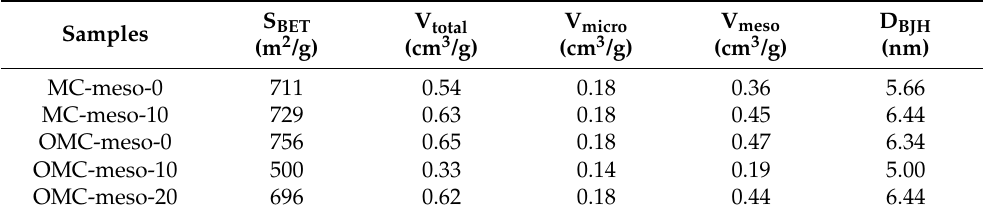
Figure 5. Nitrogen sorption isotherms ( a ) and pore-size distribution curves ( b ) of MCs and OMCs prepared with different amounts of mesophase pitch. Table 3. Textural and structural properties of MCs and OMCs prepared with different amounts of mesophase pitch.